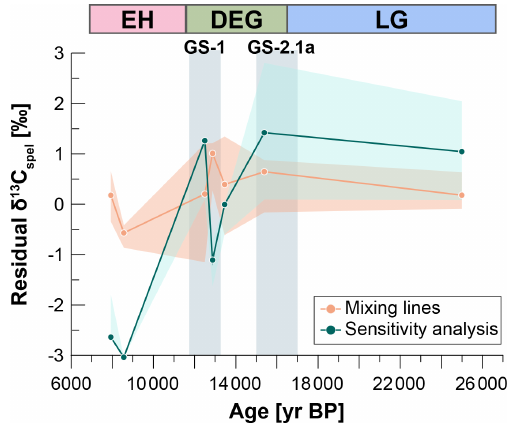
Figure 7. Residual δ 13 C spel calculated as the difference between measured and modelled δ 13 C spel over